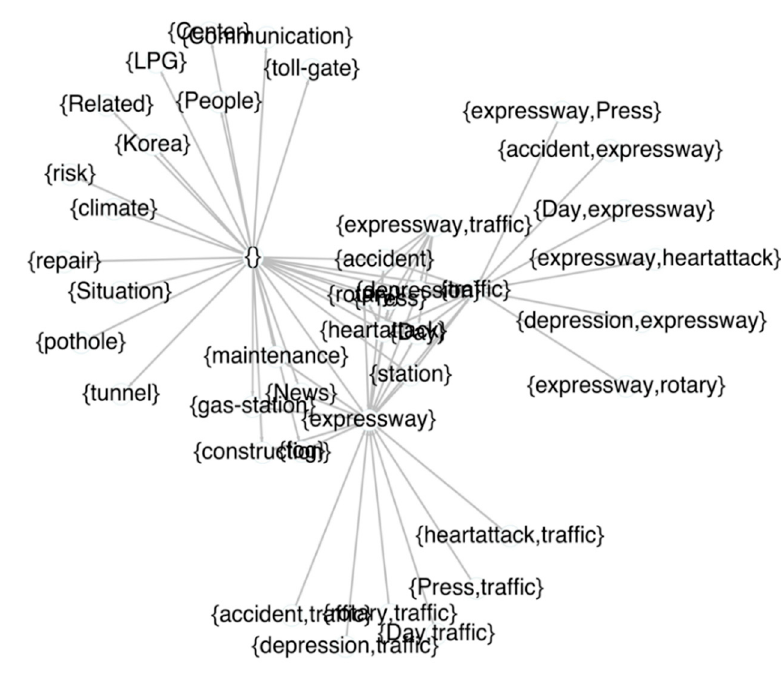
Figure 10. Non-Optimized Associative Knowledge Graph.